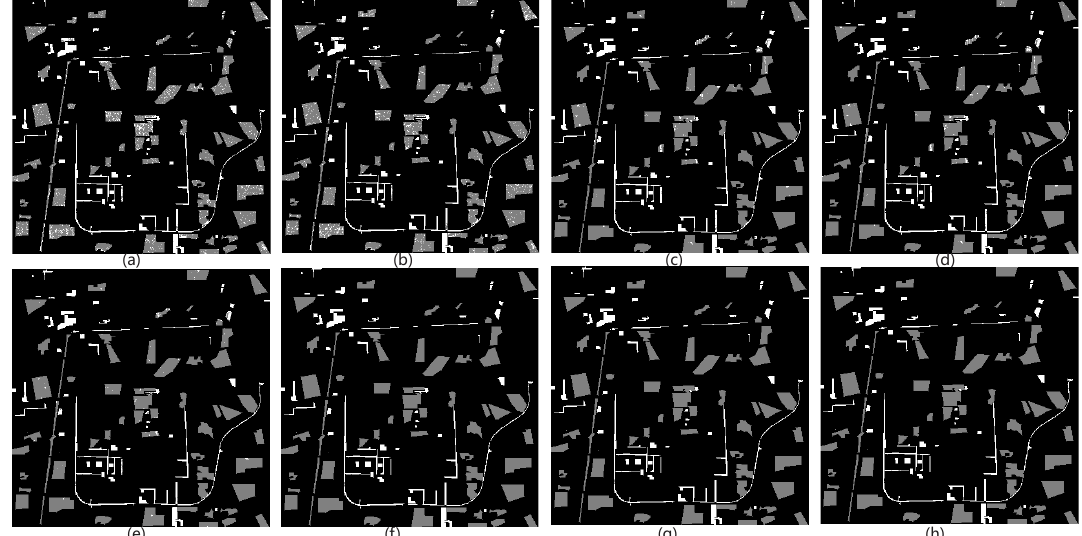
Figure 8. Binary change maps of Taizhou data set. ( a ) CVA. ( b ) IRMAD. ( c ) SCCN. ( d ) S-CNN+Threhold. ( e ) S-CNN+SVM. ( f ) SRDL. ( g ) Our proposed SSJLN. ( h ) Ground truth. The background is black, unchanged samples are gray, and changed samples are